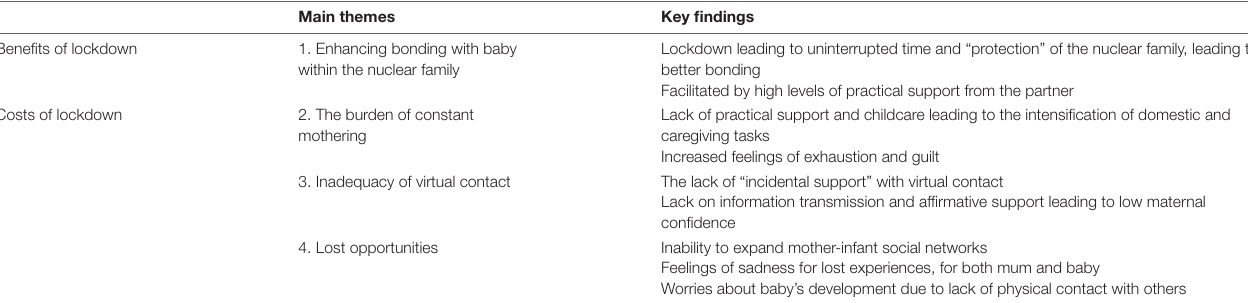
TABLE 3 | Summary of themes and key findings from our qualitative